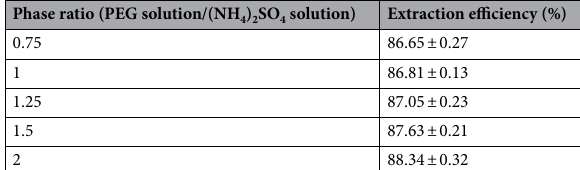
Phase ratio (PEG solution/(NH 4 ) 2 SO 4 solution)